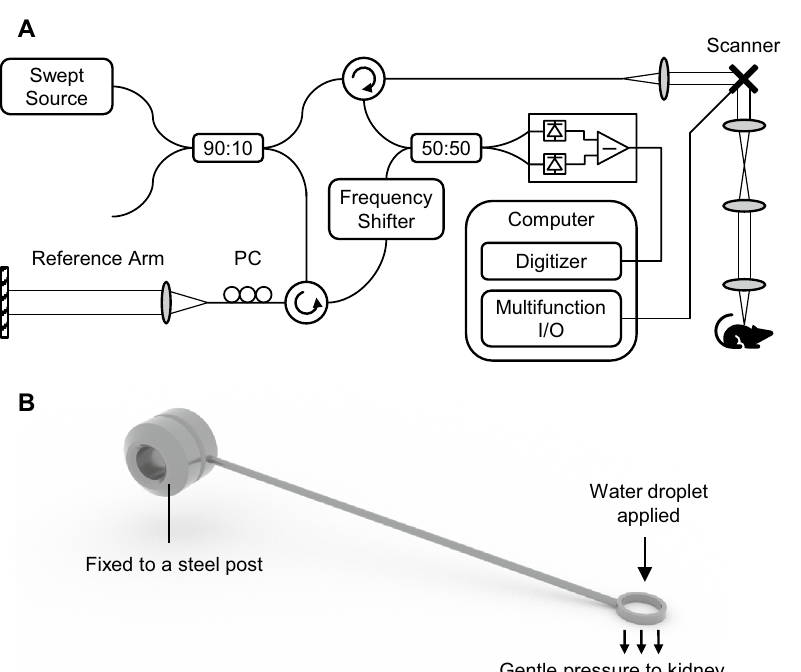
Figure 1. Optical instrumentation used for murine kidney OCTA imaging. ( A ) Schematic of the SS-OCT system operating at 1300-nm wavelength and 220.4-kHz A-scan rate. ( B ) Custom fixing tool designed for reducing pulsating and breathing motion of the kidney while imaging. Water droplet was applied inside the ring to move the reflective interface outside of the imaging